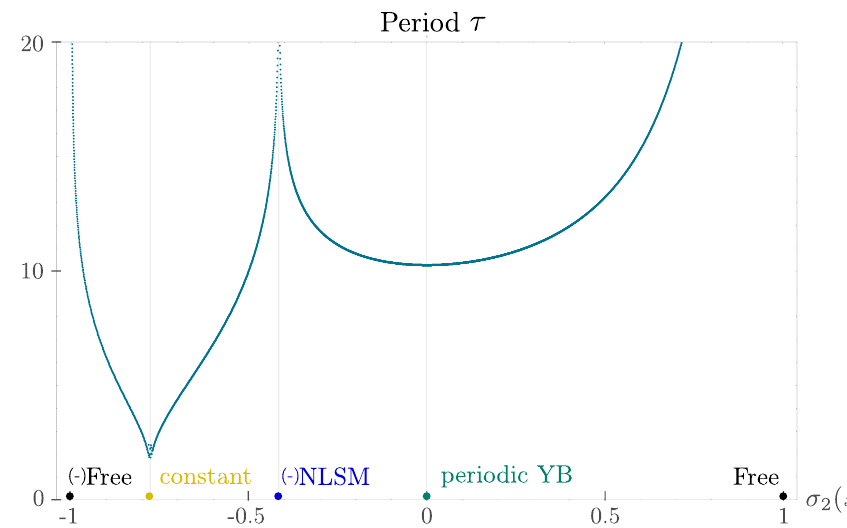
Figure 8 . Period (cid:28) (in the real (cid:18) direction) of the S-matrices obtained numerically along the curve de(cid:12)ning the boundary of the s (cid:3) = 2 m 2 plane for N = 7. The period diverges for free theory and the non-linear sigma model, has a local minimum at the periodic Yang-Baxter solution and approaches zero for the constant solution (the plot presents some noise around the latter since the numerics have a hard time converging for small